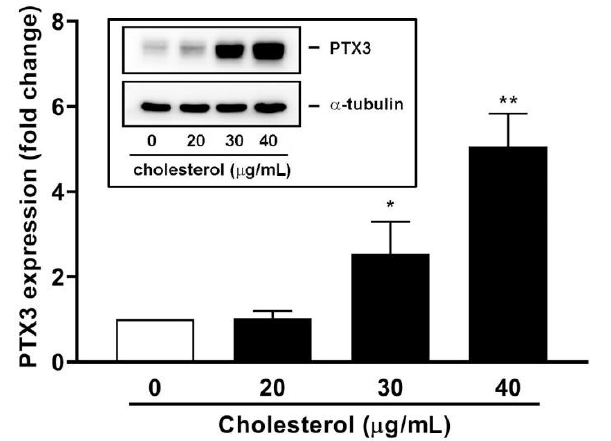
Figure 6. Effect of cholesterol on PTX3 protein expression. The fibroblasts were incubated with water-soluble cholesterol for 16 h. Western blot analysis and densitometry were performed to examine protein expression level ( n = 4). Inset panel is a representative result of WB results. * p < 0.05 and ** p < 0.01 versus control (0 μ g/mL).